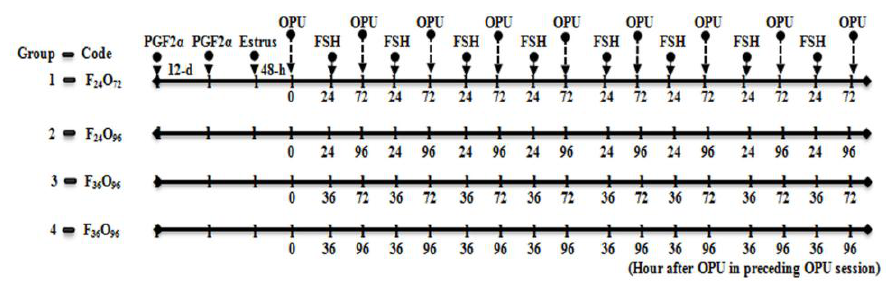
Figure 1. Superstimulation protocols for repeated OPU in Thai native